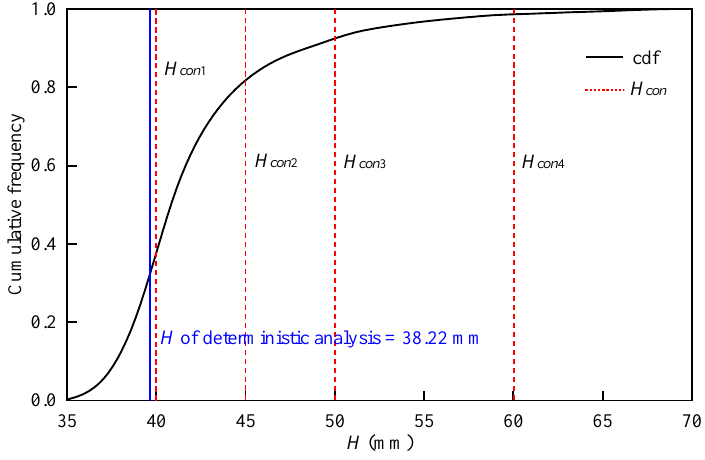
Figure 14. CDF of surface settlement with various control standard values.